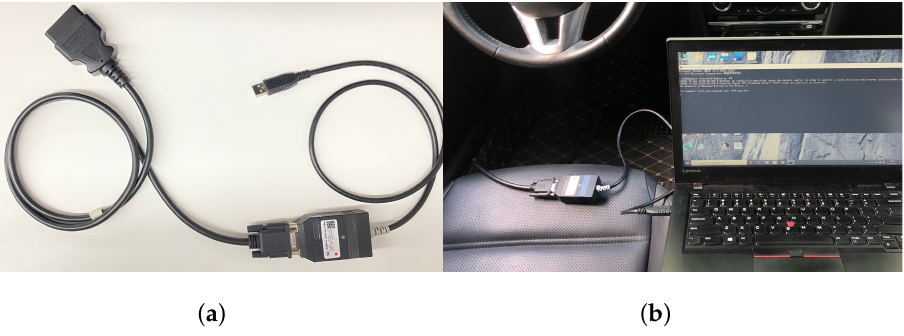
Figure 3. Data collection equipment and environment. ( a ) Combination cable for data collection; ( b ) In-vehicle data collection